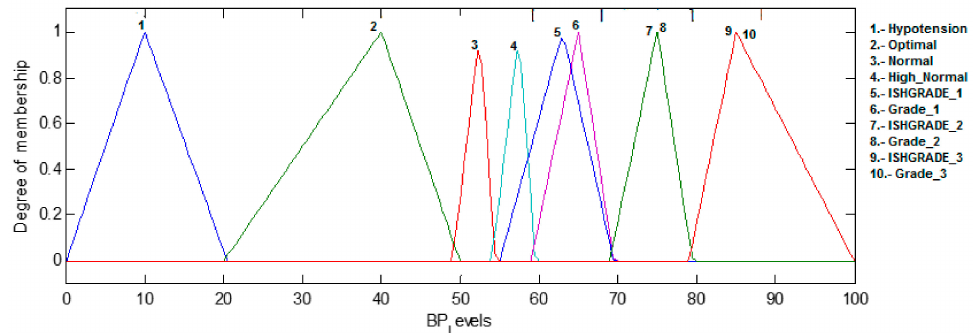
Figure 10. BP_Levels is the output of the fuzzy logic classifier